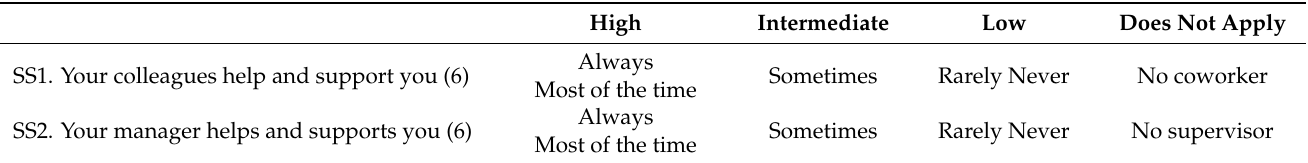
Table A3. Social support (2